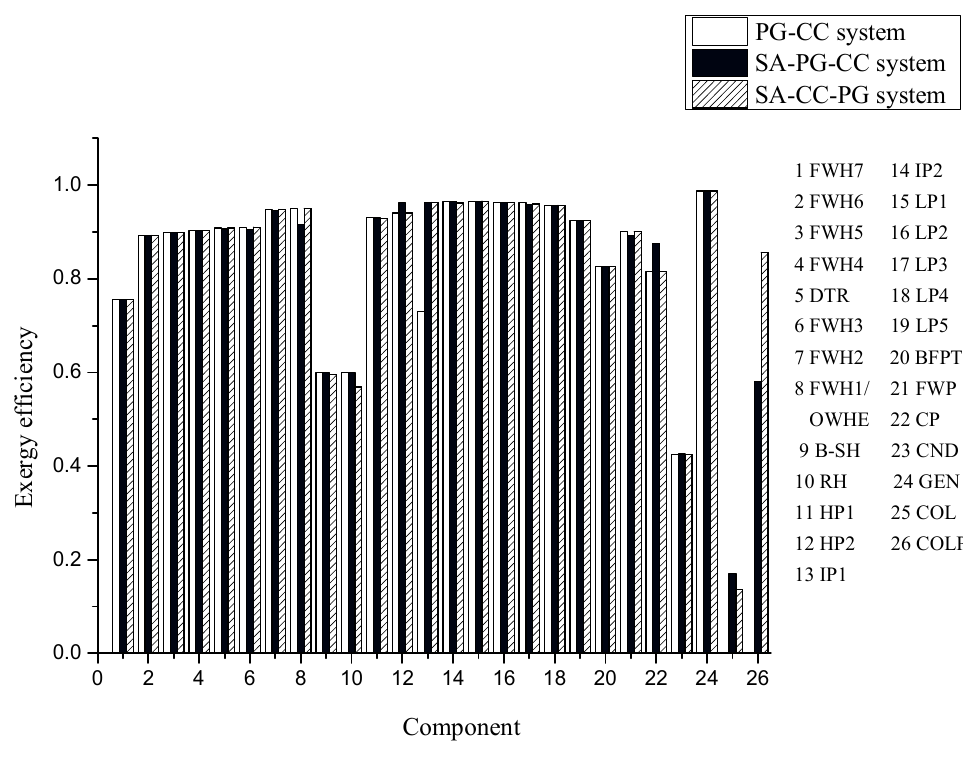
Figure 10. Exergy efficiency of each component in all three systems: coal-fired power-generation system with MEA-based CO 2 capture (PG-CC), solar-aided coal-fired power generation with CO 2 capture (SA-PG-CC) and solar-aided CO 2 capture coal-fired power generation (SA-CC-PG). Note: BFPT = feed-water pump turbine; SH = boiler superheater; CND = condenser; COL = collector; COLP = collector oil-pump; CP = condenser water pump; DTR = deaerator; FWH = feed-water heater; FWP = feed-water pump; GEN = generator; HP = high-pressure turbine; IP = intermediate-pressure turbine; LP = low-pressure turbine; OWHE = oil–water heat exchanger; RH = reheater.